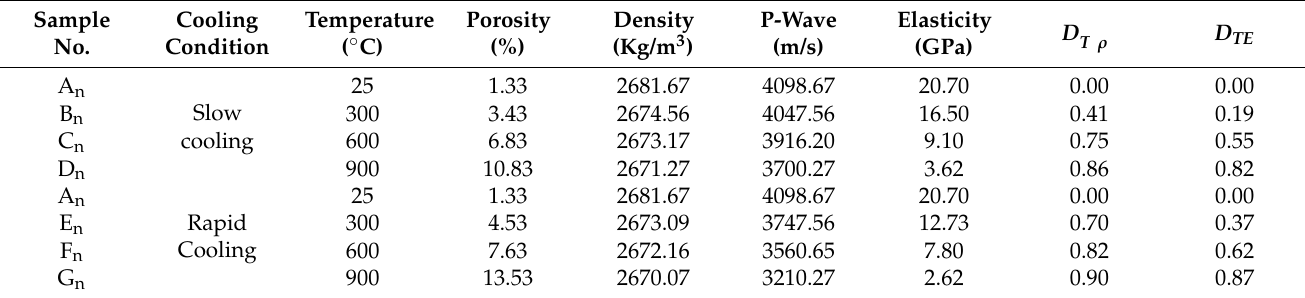
Table 1. Thermal damage factors under slow cooling and rapid